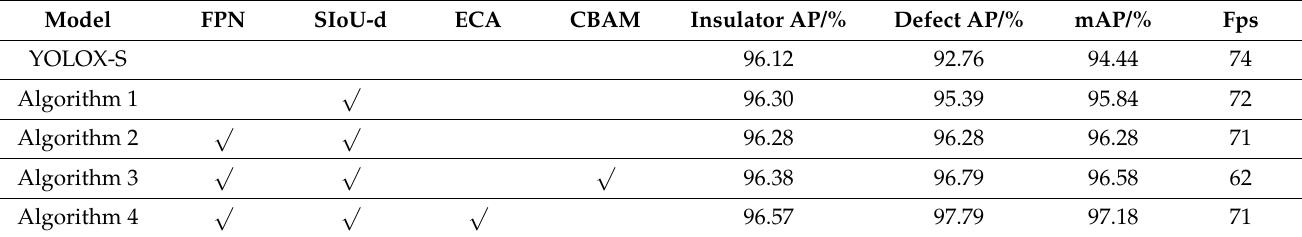
Table 4. The ablation experiments of different improvement